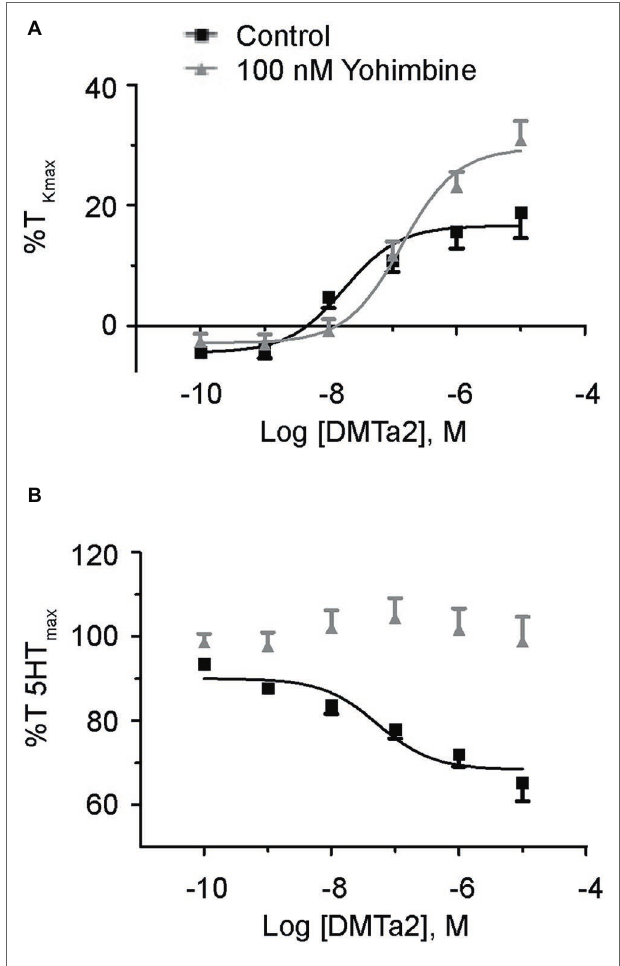
FIGURE 3 | Dexmedetomidine causes contraction and relaxation of normoxic fetal pulmonary arteries. Dose-response curves of pulmonary arterial rings exposed to 100 pM to 10 μM of dexmedetomidine in an additive manner from normoxic fetal sheep in the absence (A) and presence (B) of 10 μM serotonin. Gray lines and triangles are for dexmedetomidine contraction (A) or relaxation (B) in the presence of yohimbine, and black lines and boxes are for dexmedetomidine contraction (A) or relaxation (B) in the presence of vehicle-control (DMSO). Solid lines indicate log agonist vs. response curves that are plotted in relation to the maximal contraction induced by initial stimulation of (A) 125 mM K + Krebs-Henseleit solution (%T Kmax ) or (B) 10 μM serotonin. Points and error bars indicate mean ± S.E.M. Numbers of animals for each group are provided in the “Methods”